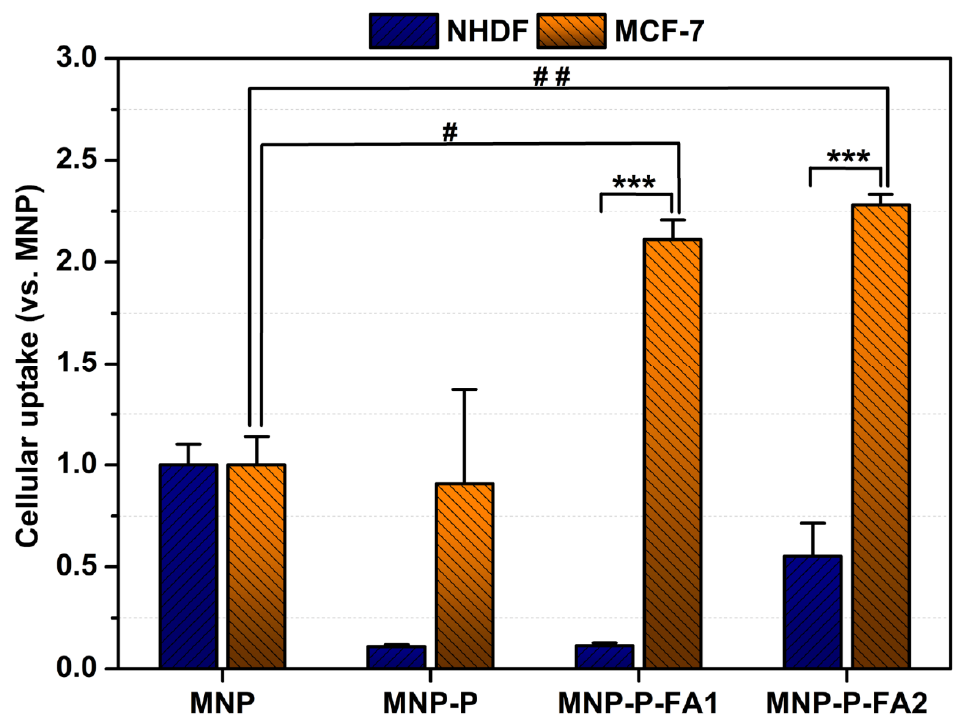
Figure 11. Cellular uptake of MNP, MNP-P, MNP-P-FA1 and MNP-P-FA2 (40 μ g/mL) in normal human dermal fibroblasts (NHDF) and breast adenocarcinoma (MCF-7) cells after 24 h. Experiments were performed in triplicate, intracellular iron in each well was normalized to its respective protein content, and cellular uptake of nanocarriers was expressed as fold change of MNP uptake. *** p < 0.001 vs. NHDF cells (Student’s t -test); # p < 0.05, ## p < 0.01 vs. MNP (one-way ANOVA).